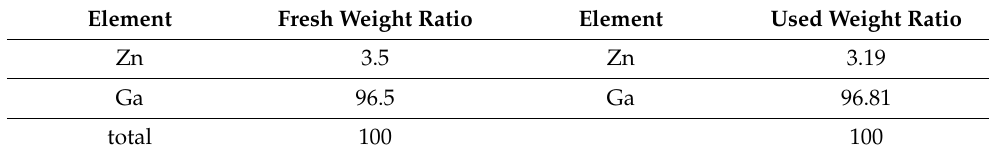
Figure 7. ( a ) UV–vis absorption curves of the MO solution, ( b ) the cycling degradation performance for the degradation of MO using the Ga 2 O 3 /ZnO composite, and ( c ) change of total organic carbon content in MO solution. Table 2. Atomic weight ratio before and after catalyst degradation is obtained by EDS of